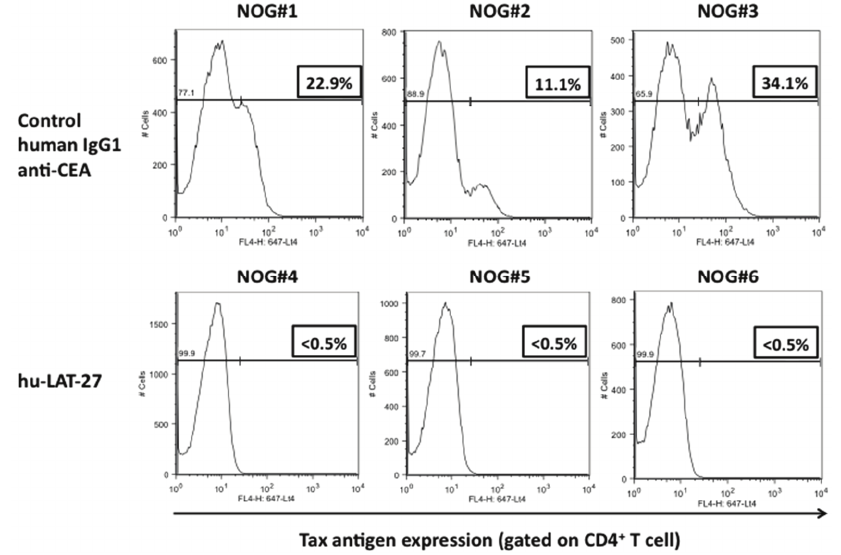
Figure 4. Protection of hu-PBL-NOG mice against HTLV-I by hu-LAT-27. The Mitomycin C (MMC)-treated HTLV-I-infected ILT-M1 (1 × 10 6 cells) was mixed with freshly isolated PBMCs (2